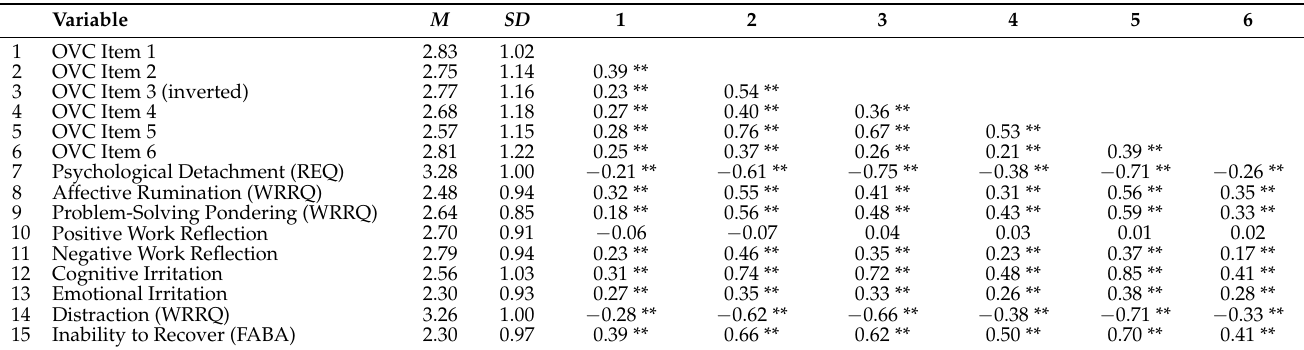
Table 2. Correlations of each OVC item with the Scores of the other Variables (Sample 1).